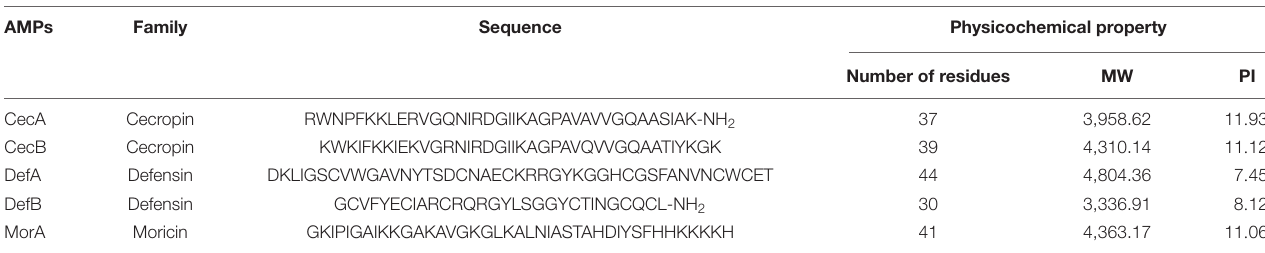
TABLE 2 | Amino acid sequences and physicochemical properties of the designed